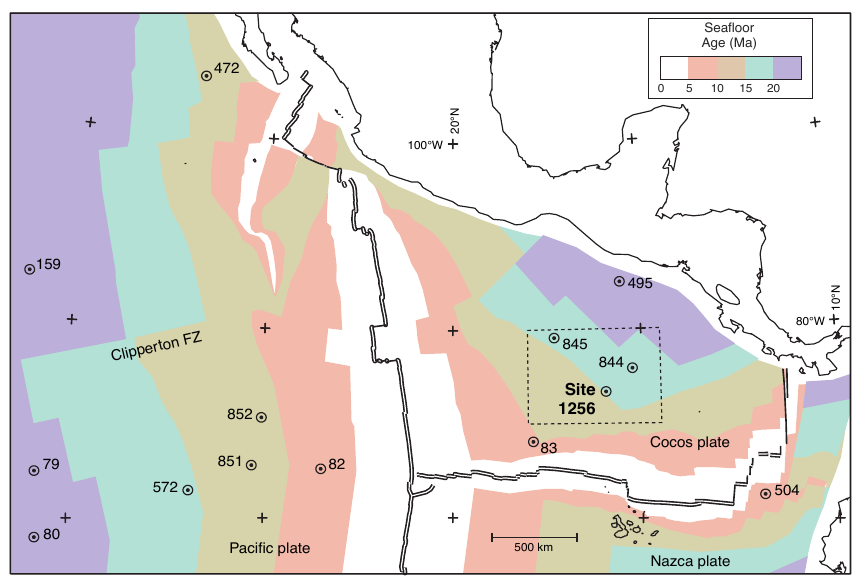
Figure 1. Age map of the Cocos plate and East Pacific Rise with isochrons at 5-My intervals, converted from magnetic anomaly identifications according to timescale of Cande and Kent (1995). The wide spacing of 10–20 Ma isochrons to the south reflects the extremely fast (200–220 mm yr -1 ) full spreading rate. The locations of deep drill holes into the oceanic crust at Sites 1256 and 504 are